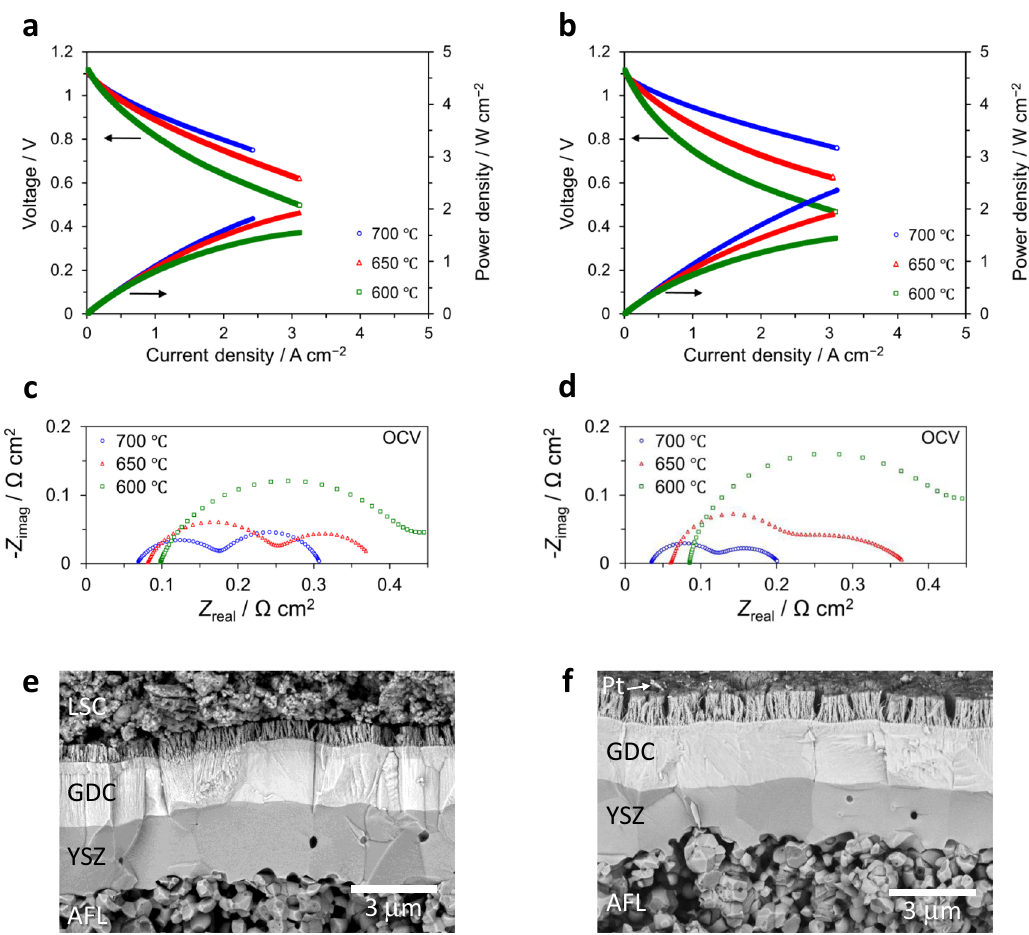
Fig. 7 Comparison of electrochemical performance and microstructure of anode-supported cells. a Current – voltage ( I – V ) and current – power ( I – P ) curves evaluated at various temperatures (700 °C: blue circles, 650 °C: red triangles, 600 °C: green squares) of the anode-supported cells utilizing nanoengineered cathode layers comprised of nanoporous LSC and LSCF-GDC nanocomposite (Sample 8 con fi guration, see Supplementary Table 1) and tested using different current collectors. LSC paste was utilized for the cell on the left-hand side, whereas Pt paste was used for the one on the right-hand side. The current load is limited to 3 A/cm 2 . The performance at 700 °C for the cell tested with LSC paste is inferior compared to the one where Pt paste was used; however, their performances are comparable at lower temperatures (650 and 600 °C). These results suggest that the material used for the current collection is an important consideration when evaluating the electrochemical performance. The active electrode area for both cells is 0.785 cm 2 . c , d Corresponding impedance spectra at OCV and various temperatures. e , f Representative cross-sectional SEM images showing the cells after testing using LSC paste ( e ) and Pt paste ( f ) as current